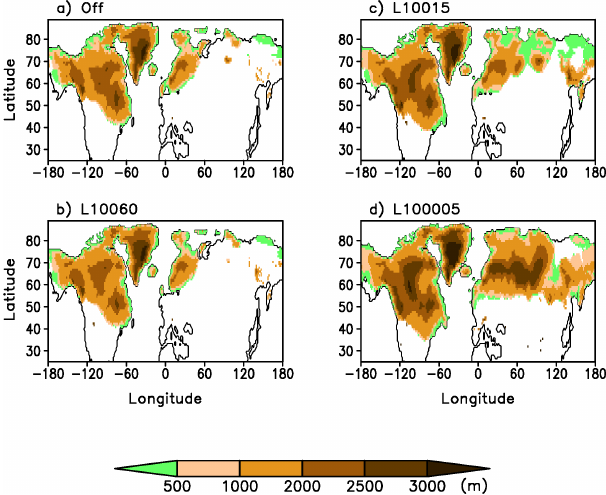
Figure 9. Simulated ice sheet extent and elevation (m) at LGM in control simulation without radiative forcing by atmospheric dust (a) , and experiments using solution L1 with RI = 0 . 0060 (b) , RI = 0 . 0015 (c) and RI = 0 . 0005 (d)